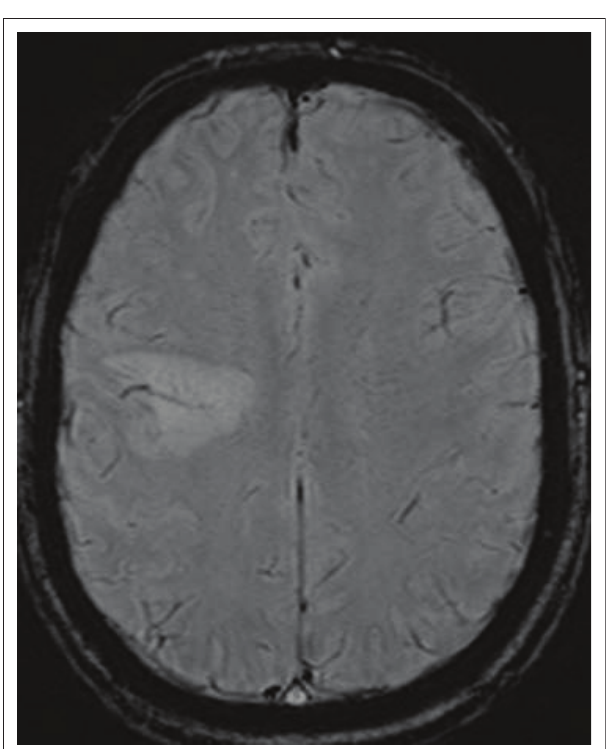
FIGURE 2: Axial SWI MR image.